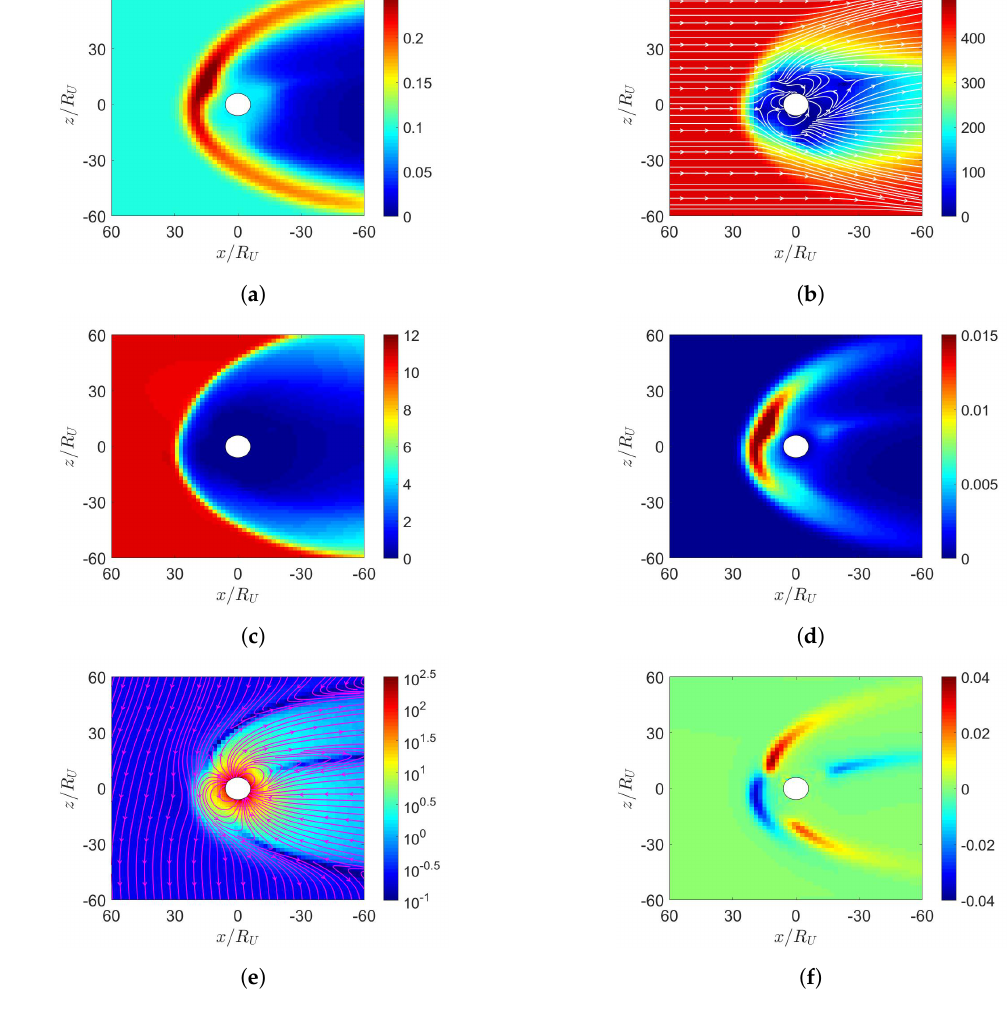
Figure 17. Distributions around Uranus of ( a ) n (cm − 3 ), ( b ) ¯ u xz (km/s), ( c ) magnetosonic Mach number, ( d ) P (nPa), ( e ) ¯ B xz (nT), ( f ) J y (nA/m 2 ); initial dipole tilts up and towards the sun, southward IMF, t = 85.4